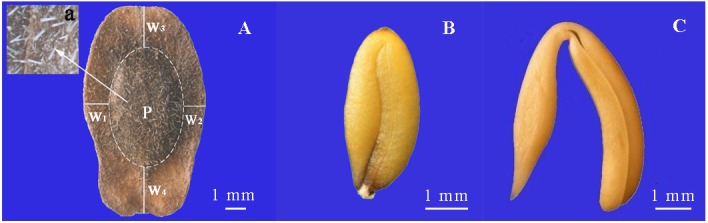
Morphology of silicle (A), seed (B) and embryo (C) of Isatis violascens.a (inset), trichomes. W1, W2, W3 and W4, wing width. W1 is left side of silicle; W2 right side of silicle; W3 upper end of silicle; and W4 peduncle end of silicle. P, seed covered by pericarp.